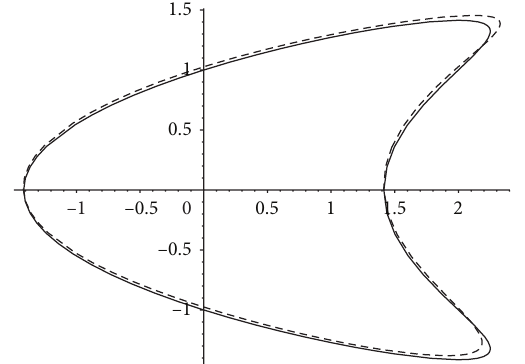
Figure 3: The periodic orbit for 𝜀 = 0 and the analytical and numerical approximations of the limit cycle for 𝜀 = 1/20 of system